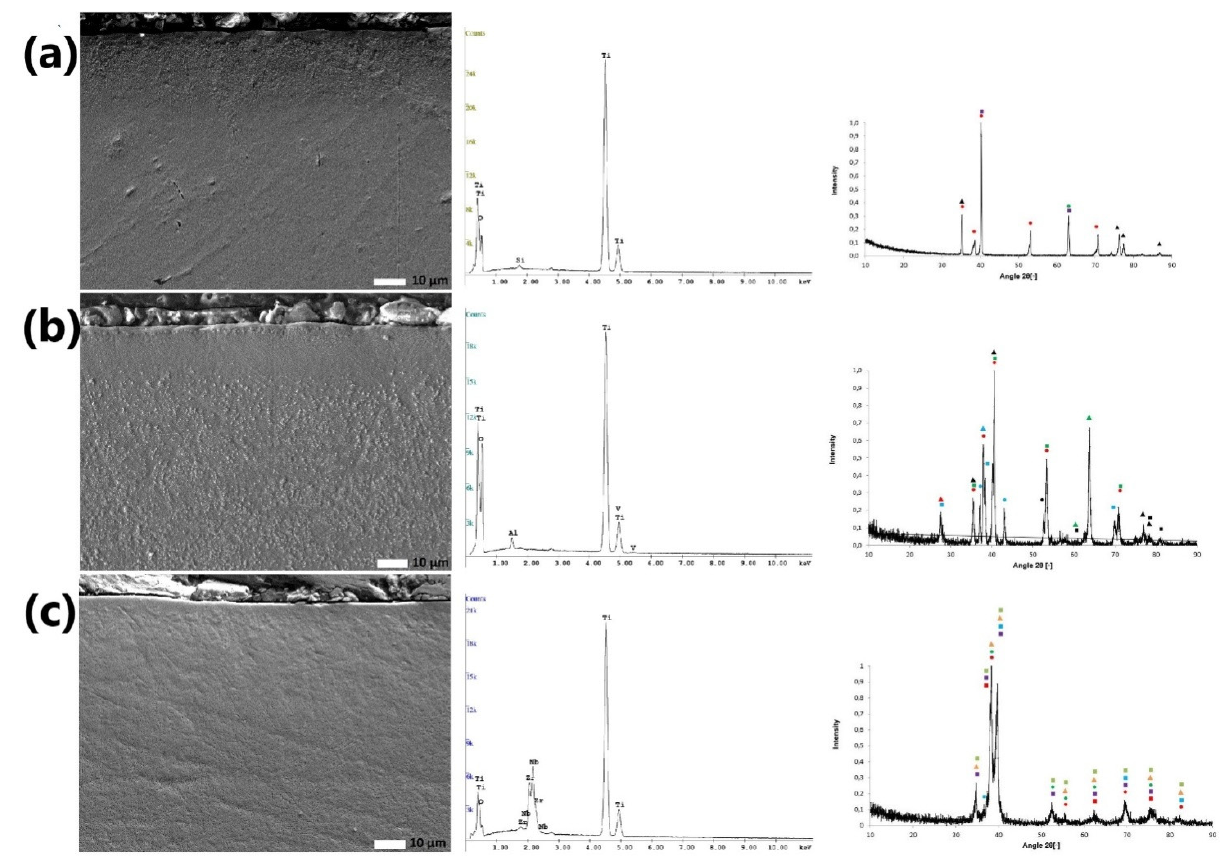
Figure 4. The microstructures of the cross sections of the obtained surface layers of the samples and EDS and XRD diffractograms: ( a ) LT1: ⬤ —Ti, ▲ —Ti6 O, ■ —O0.48 Ti, ⬤ —O Ti; ( b ) LT2: ■ —Ti O2, ▲ —Ti3 O, ⬤ —Ti, ■ —Al Ti3, ▲ —Ti6 O, ▲ —Al-Ti-O2, ⬤ —Ti O, ⬤ —Ti2 O3, ■ –V7 O3, ▲ —Al8.00 V16.00 O32.00; ( c ) LT3: ⬤ —Ti, ■ —O0.48 Ti, ▲ —O2 Zr0.958, ■ —Nb6 O12 Ti12, ■ —Nb, ⬤ —O Ti, ■ —O2 Ti.